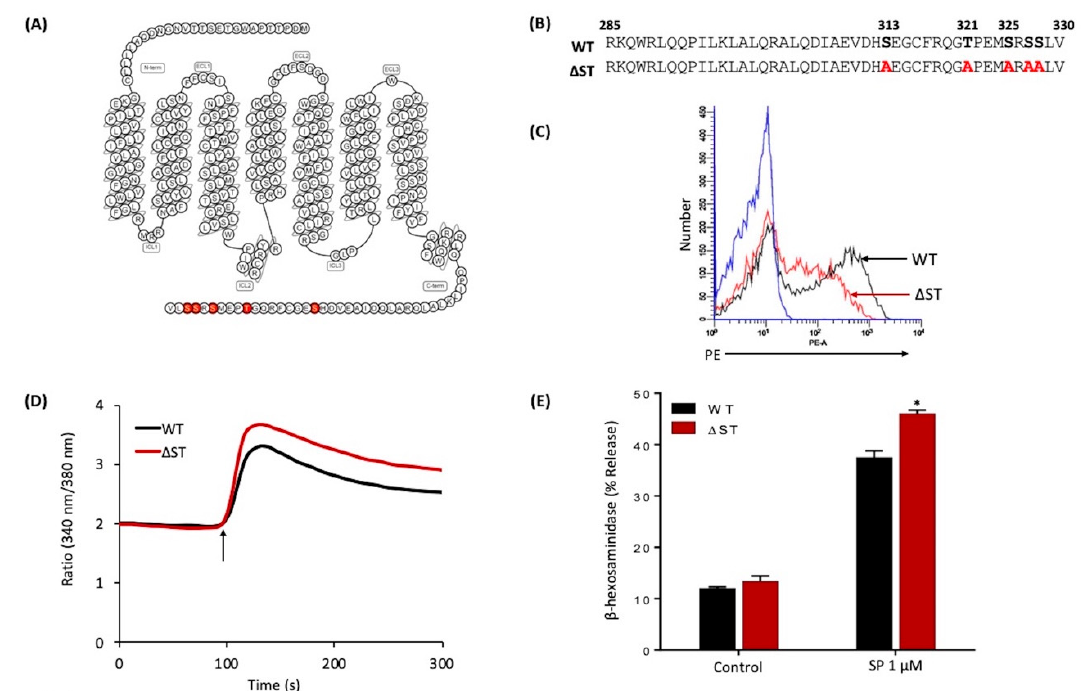
Figure 5. Effects of Ser/Thr residues on MRGPRX2’s carboxyl-terminus on cell surface expression, SP-induced Ca 2+ mobilization, and degranulation in transiently transfected RBL-2H3 cells. ( A ) Snake diagram of secondary structure of MRGPRX2. Each circle represents amino acid residue with one letter code. Solid red backgrounds denote Ser/Thr residues; ( B ) schematic representation of the carboxyl-terminus of MRGPRX2 (WT) and a phosphorylation-deficient mutant in which all Ser/Thr were replaced with Ala ( △ ST-MRGPRX2); ( C ) cell surface expression of WT and △ ST-MRGPRX2 was determined by flow cytometry using PE-anti-MRGPRX2 antibody. Representative histograms for WT-MRGPRX2 (black line), △ ST-MRGPRX2 (red line), and control untransfected cells (blue line) are shown; ( D ) cells expressing WT and △ ST-MRGPRX2 were loaded with Fura-2 and intracellular Ca 2+ mobilization in response to SP (1 μ M) was determined. Data shown are representative of three independent experiments; ( E ) cells were exposed to a buffer (control) or SP (1 μ M) for 30 min, and β -hexosaminidase release was determined. All data points are the mean ± SEM of at least three experiments performed in triplicate. Statistical significance was determined by a nonparametric t -test. * p ≤ 0.05.